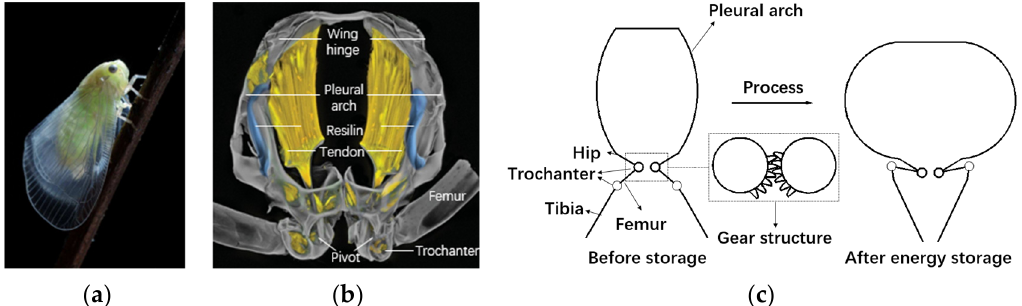
Figure 1. ( a ) Wax cicada in life; ( b ) Biological structure of the pleural arch [16]; ( c ) Simplified model of the jumping process.